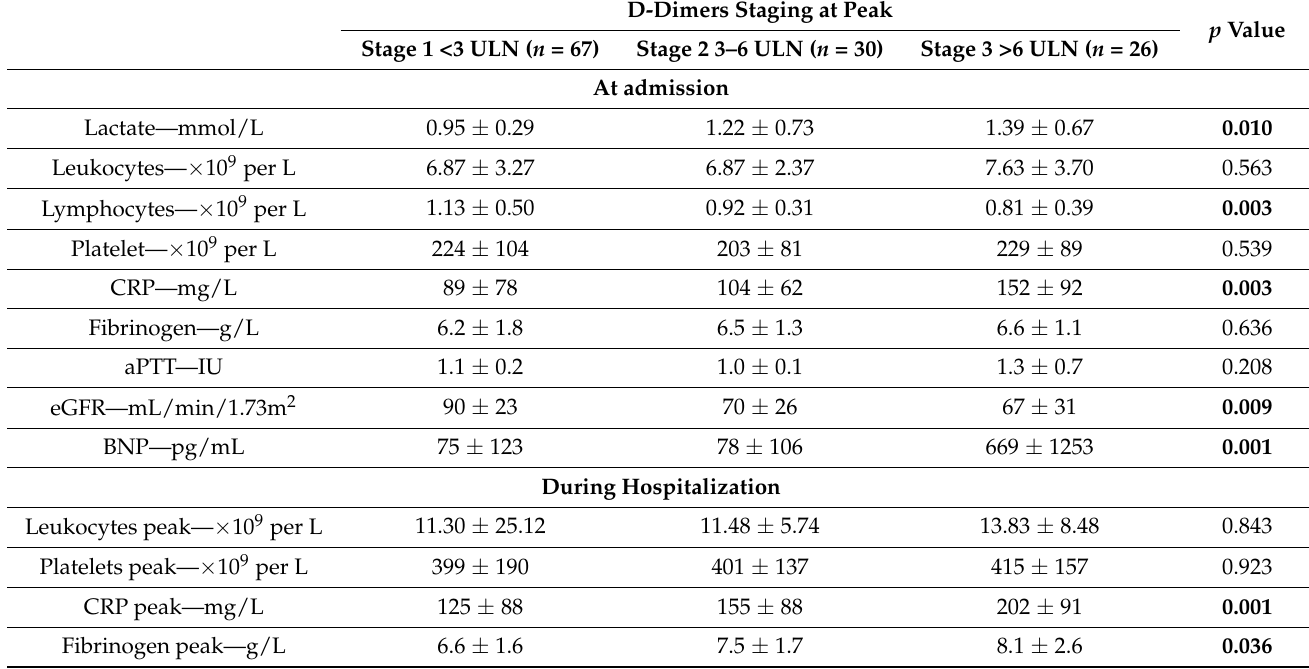
Table 2. Laboratory findings at admission and during hospitalization according to D-Dimers staging at